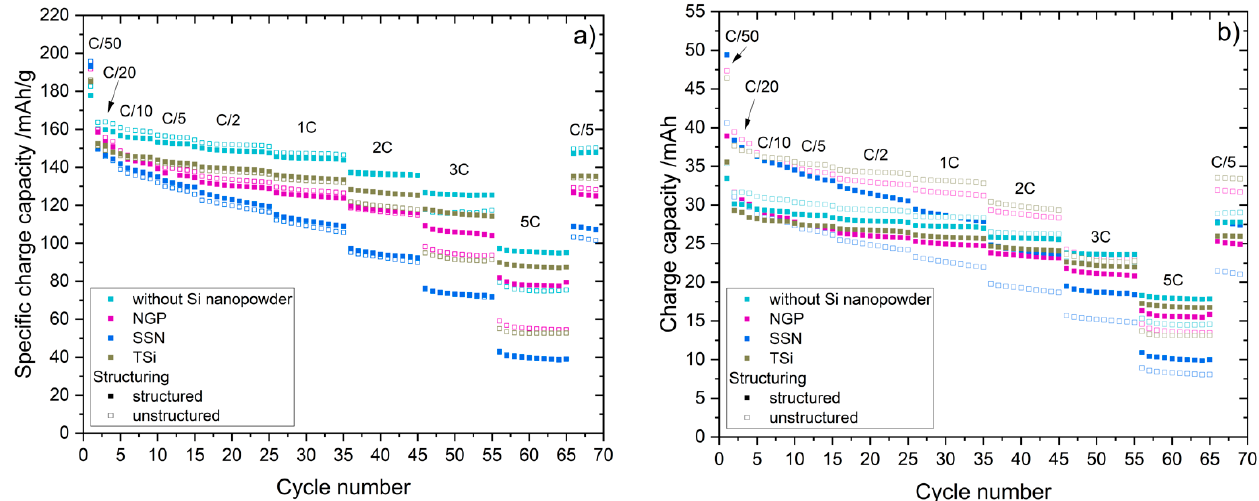
Figure 7. Rate capability tests of the pouch cells with unstructured and structured anodes. ( a ) Specific charge capacity (charge capacity normalized to the weight of the active material). ( b ) Charge capacity.